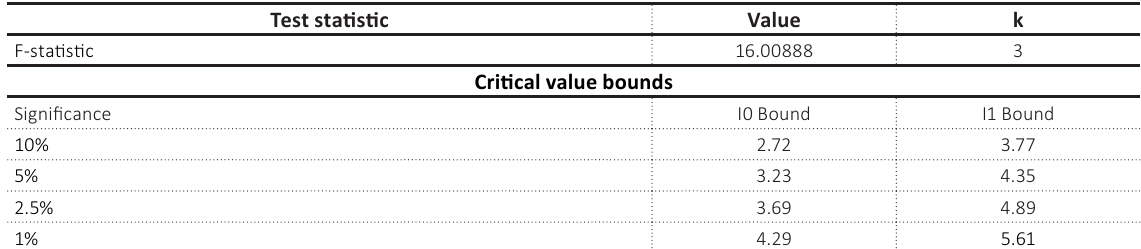
Table 3. ARDL bounds co-integration test for credit to private sector and finance for growth indicators